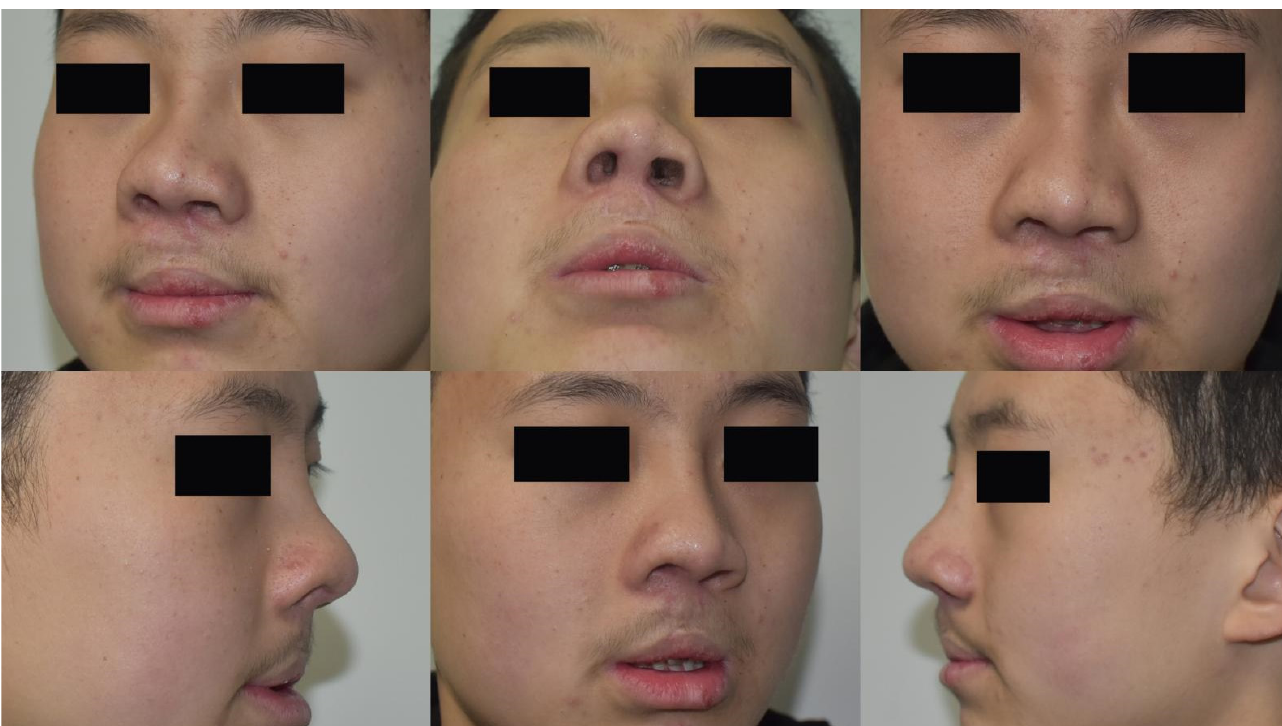
Figure 7. A 25-year-old male presented with cleft lip nasal deformity before our surgery. The photos were taken 12 months after the operation.